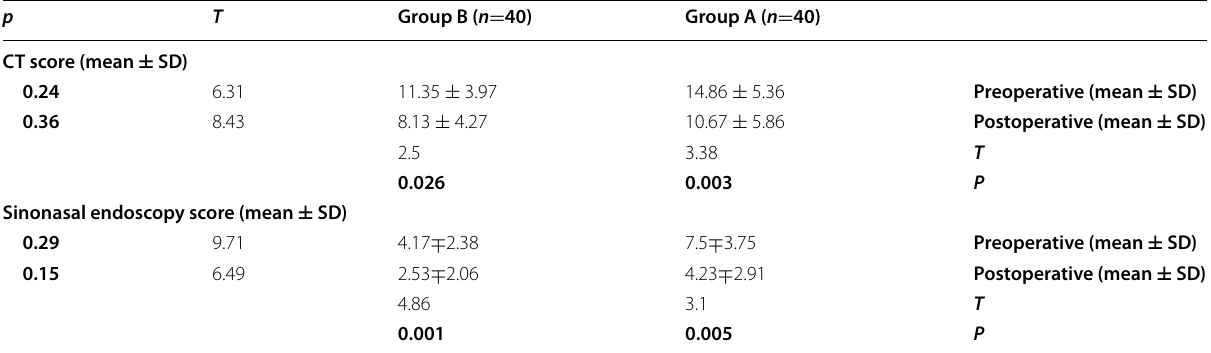
Table 3 Preoperative and postoperative evaluation parameters between the two studied groups